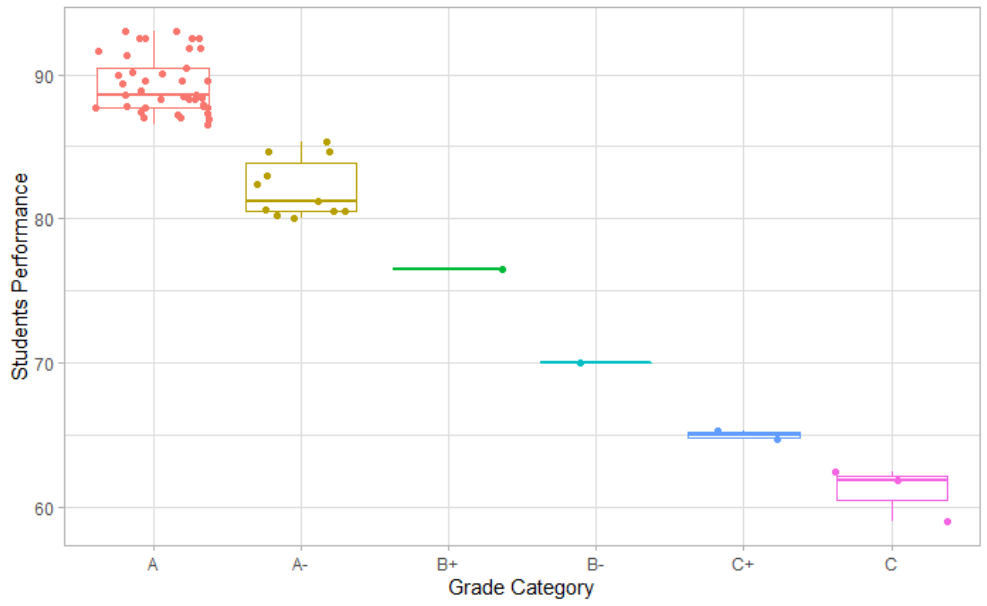
Distribution of Students’ Performance Based on Final